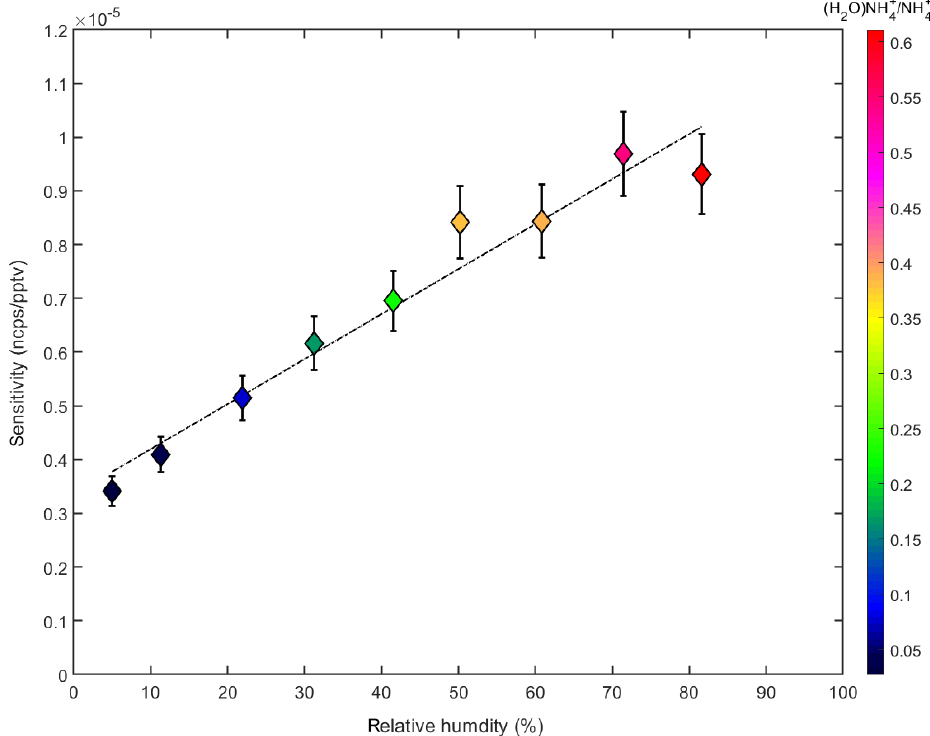
Figure 5. Dependency of the ammonia sensitivity as a function of the relative humidity (%). A linear increase with relative humidity is observed, which tracks an increase in the ratio of the (H 2 O)NH +